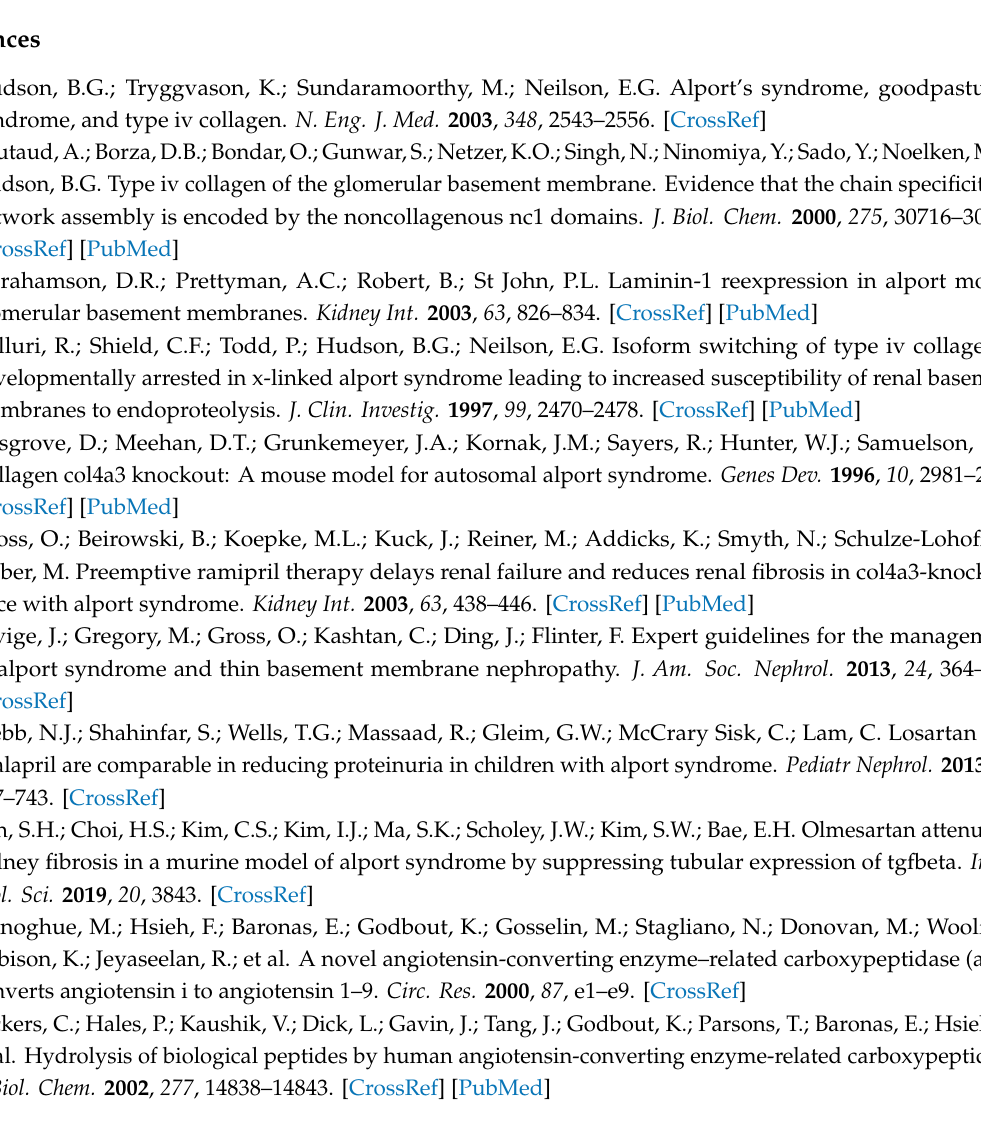
s1. Table S1: List of primary and secondary antibodies for immunohistochemistry. Table S2: List of primary and secondary antibodies for immunoblotting. Table S3: List of primer sequences for real-time qPCR. Figure S1. CG alone did not induce apoptosis in HK-2 cells. Figure S2. Raw data for immunoblotting related to Figure 2. Figure S3. Raw data for immunoblotting related to Figure 3. Figure S4. Raw data for immunoblotting related to Figure 4. Figure S5. Raw data for immunoblotting related to Figure 5. Figure S6. Raw data for immunoblotting related to Figure 6. Figure S7. Raw data for immunoblotting related to Figure 7. Figure S8. Raw data for immunoblotting related to Figure